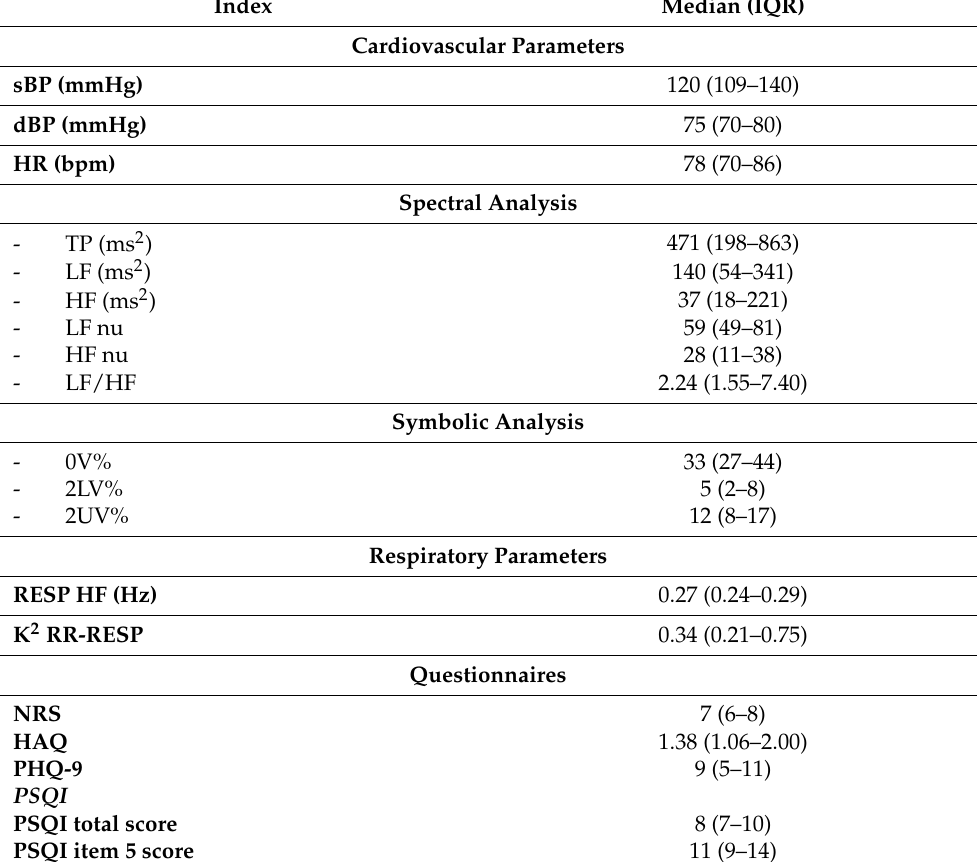
Table 2. Cardiovascular and respiratory parameters and questionnaire scores of the study population.